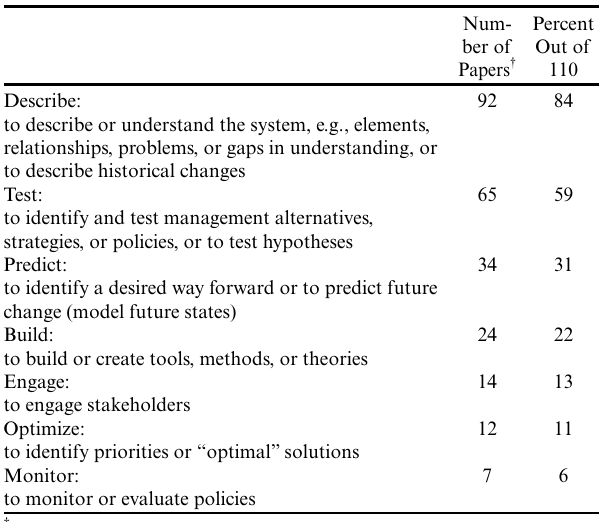
Table 2 . Ways in which tools are applied in social-ecological systems research, based on subset of 110 randomly selected